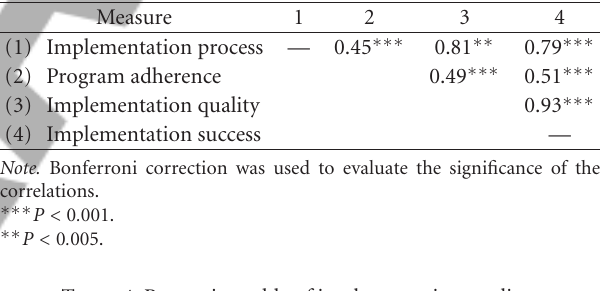
Table 3: Intercorrelations among program adherence, implementa- tion process, implementation quality, and implementation success.